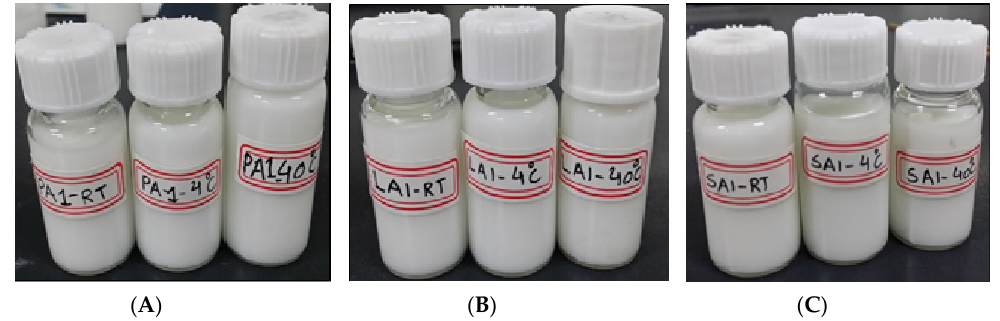
Figure 7. The physical appearance of TMS ‐ pNLCs ( A ), TMS ‐ lNLCs ( B ), and TMS ‐ sNLCs ( C ) at 4 °C, 25 °C, and 40 °C after 60 days of storage.